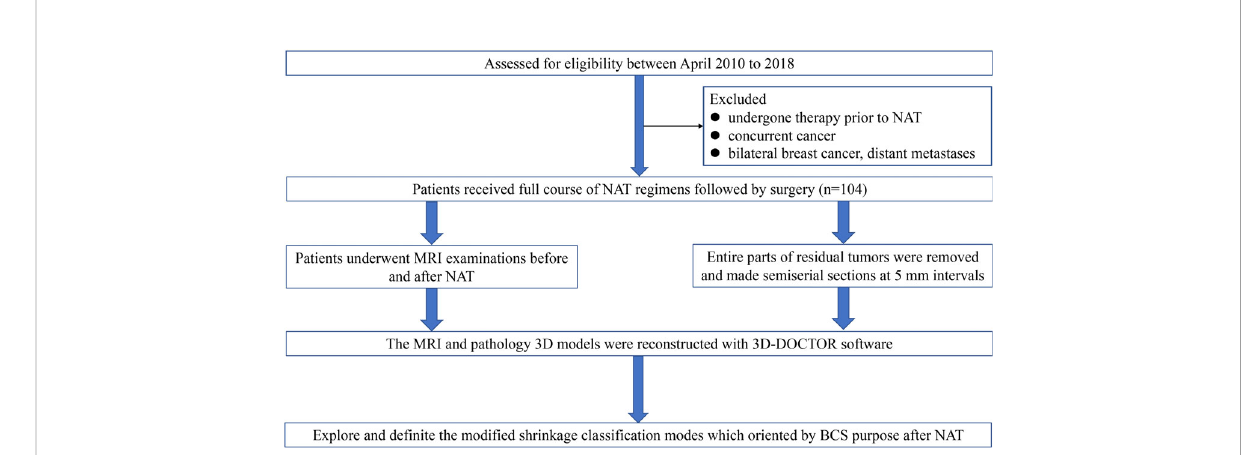
FIGURE 1 The consort diagram of the